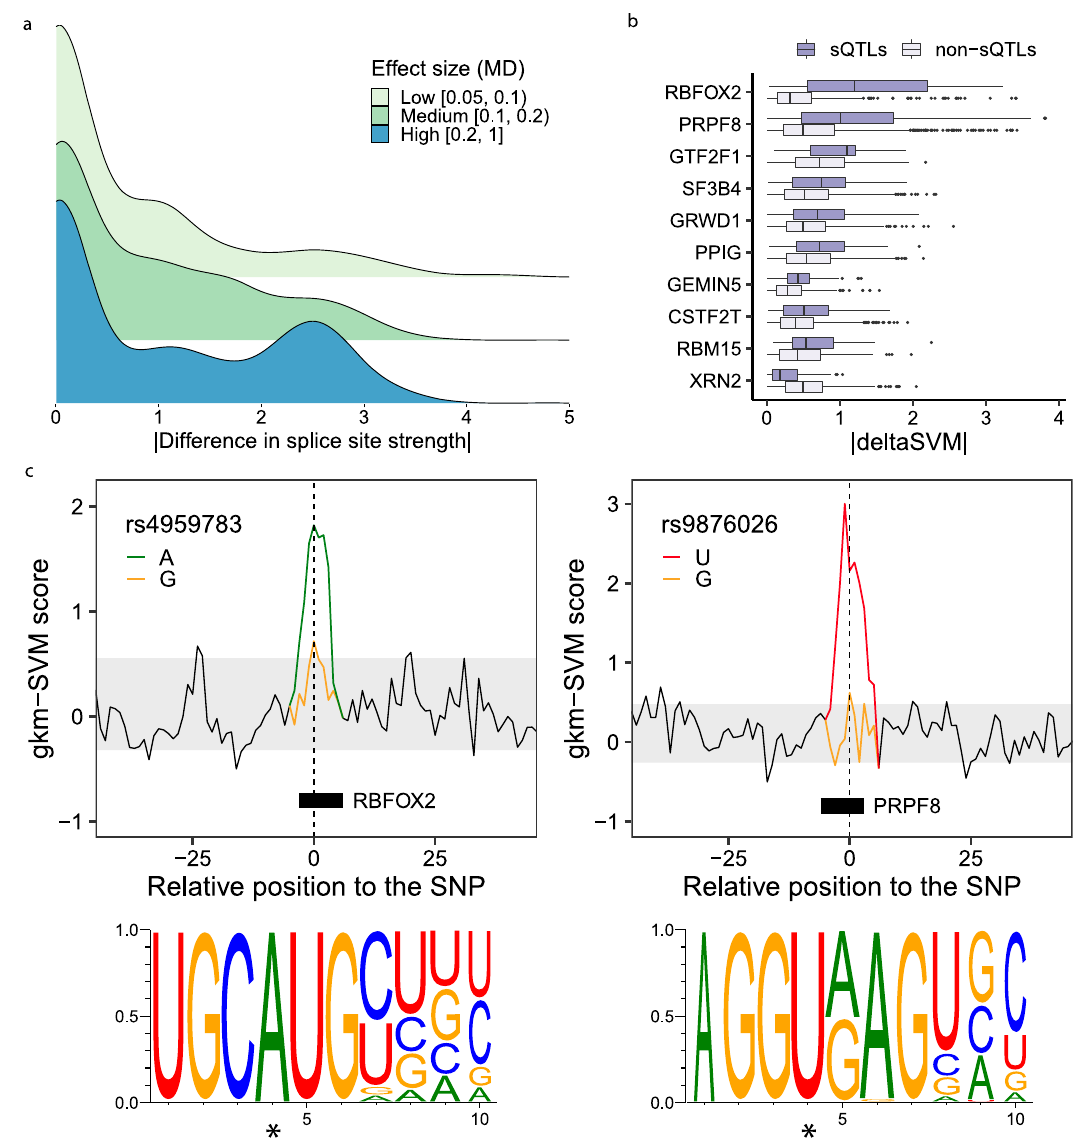
Fig. 4 Impact of sQTLs on splice sites and RBP binding sites. a Distribution of the absolute change in splice site strength for sQTLs with low, moderate and high effect sizes (MD value). b Distribution of the absolute deltaSVM value ( ∣ deltaSVM ∣ ) of sQTLs and non-sQTLs, for RBPs with signi fi cantly different mean ∣ deltaSVM ∣ between sQTLs and non-sQTLs (two-sided Wilcoxon Rank-Sum test, FDR < 0.05, total sample size for each test listed as follows: n = 509, n = 1,133, n = 376, n = 595, n = 736, n = 691, n = 345, n = 1,170, n = 373 and n = 450). RBFOX2 PRPF8 GTF2F1 SF3B4 GRWD1 PPIG GEMIN5 CSTF2T RBM15 XRN2 Data is shown as boxplots, where the box represents the fi rst to third quartiles and the median, and the whiskers indicate ± 1.5 × interquartile range (IQR). c Modi fi cation of the binding sites of the RBPs RBFOX2 (left) and PRPF8 (right) by SNPs rs4959783 (chr6:3,260,093, G/A, ∣ deltaSVM ∣ = 2.48) and rs9876026 (chr3:11,849,807, T/G in the reverse strand, ∣ deltaSVM ∣ = 4.77), respectively. The lines represent the gkm-SVM scores of all possible (overlapping) 10-mers in a 100 bp window around the SNP. Those corresponding to the 10-mers overlapping the SNP are colored according to the allele. SNP positions are marked with a dashed line. The gray area includes the 90% middle gkm-SVM scores of 10-mers not overlapping the variant. The relative location of the predicted RBP motifs and the corresponding sequence logos are also displayed. In the logos, the SNP position is marked with an asterisk. Source data for a – c are provided as a Source Data fi